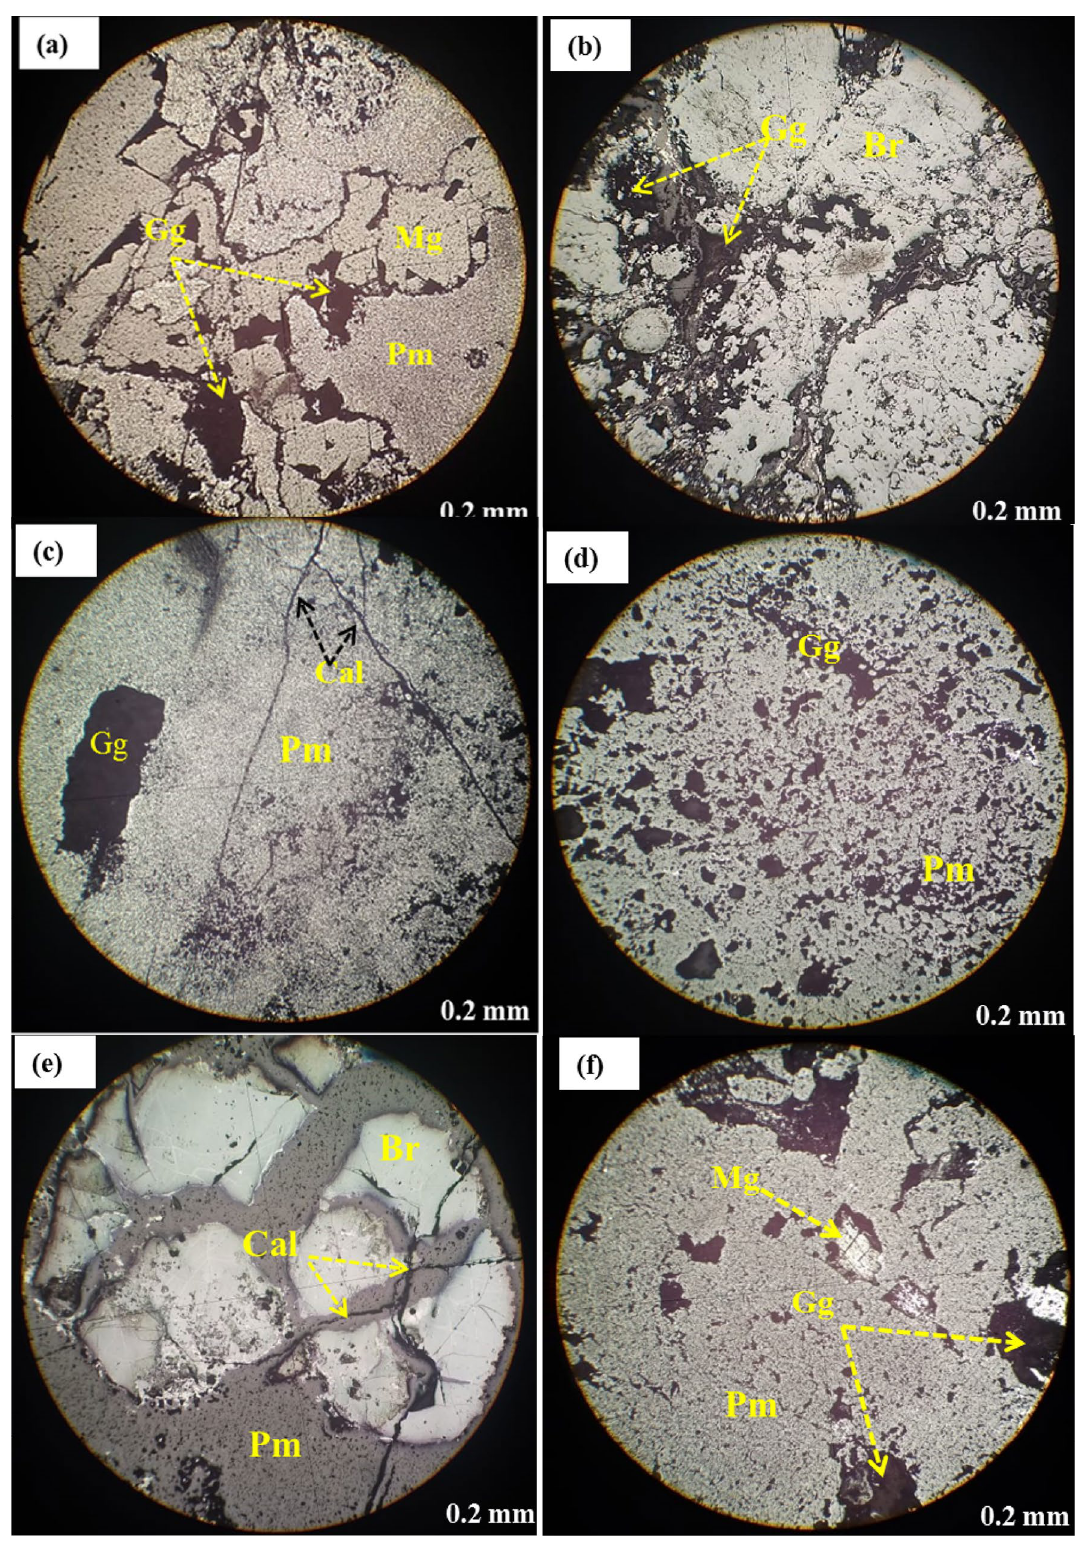
Fig. 6 Polished-section photomicrographs illustrating the of manganese ore samples captured under reflected light ore